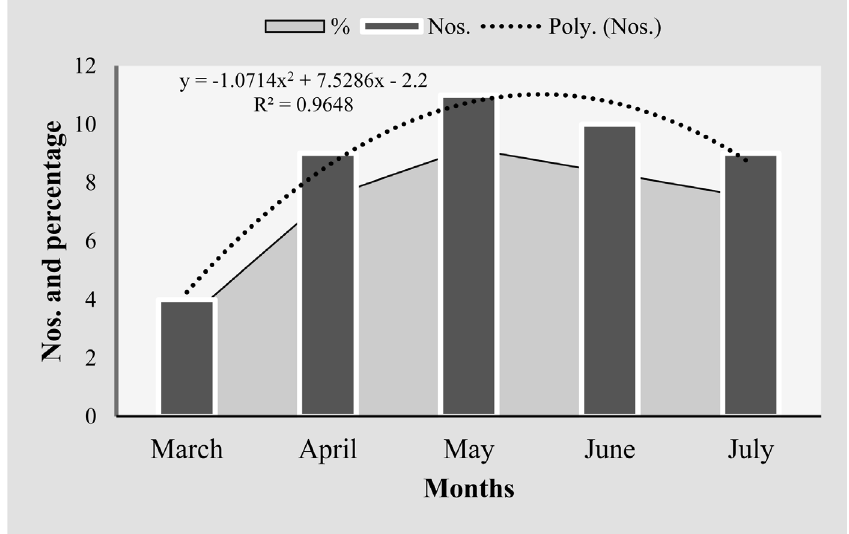
Fig. 7. Temporal changes of Womens ’ participation in the freshwater farming activities during the COVID